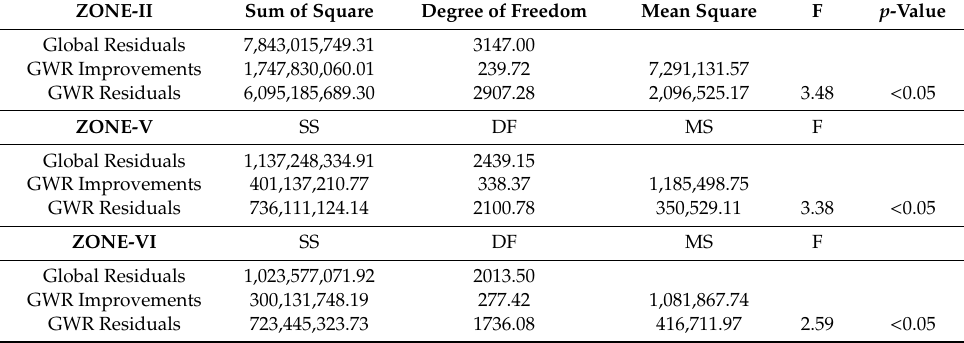
Table 10. ANOVA test of GWR improvements over OLS for each agrarian zone: zone II in the northern Montaña region, zone V in the Media region, and zone VI in the Ribera Alta Southern region. GWR: geographically weighted regression and OLS: ordinary least squares. F refers to the F-test